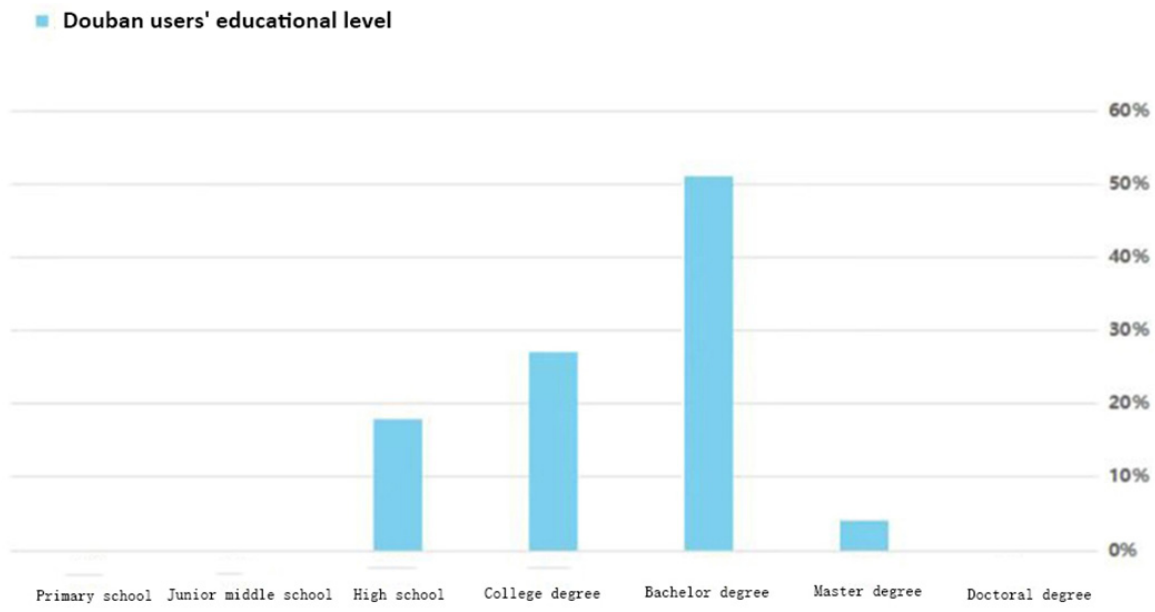
Figure 1. Educational level statistics of Douban APP users 2 .